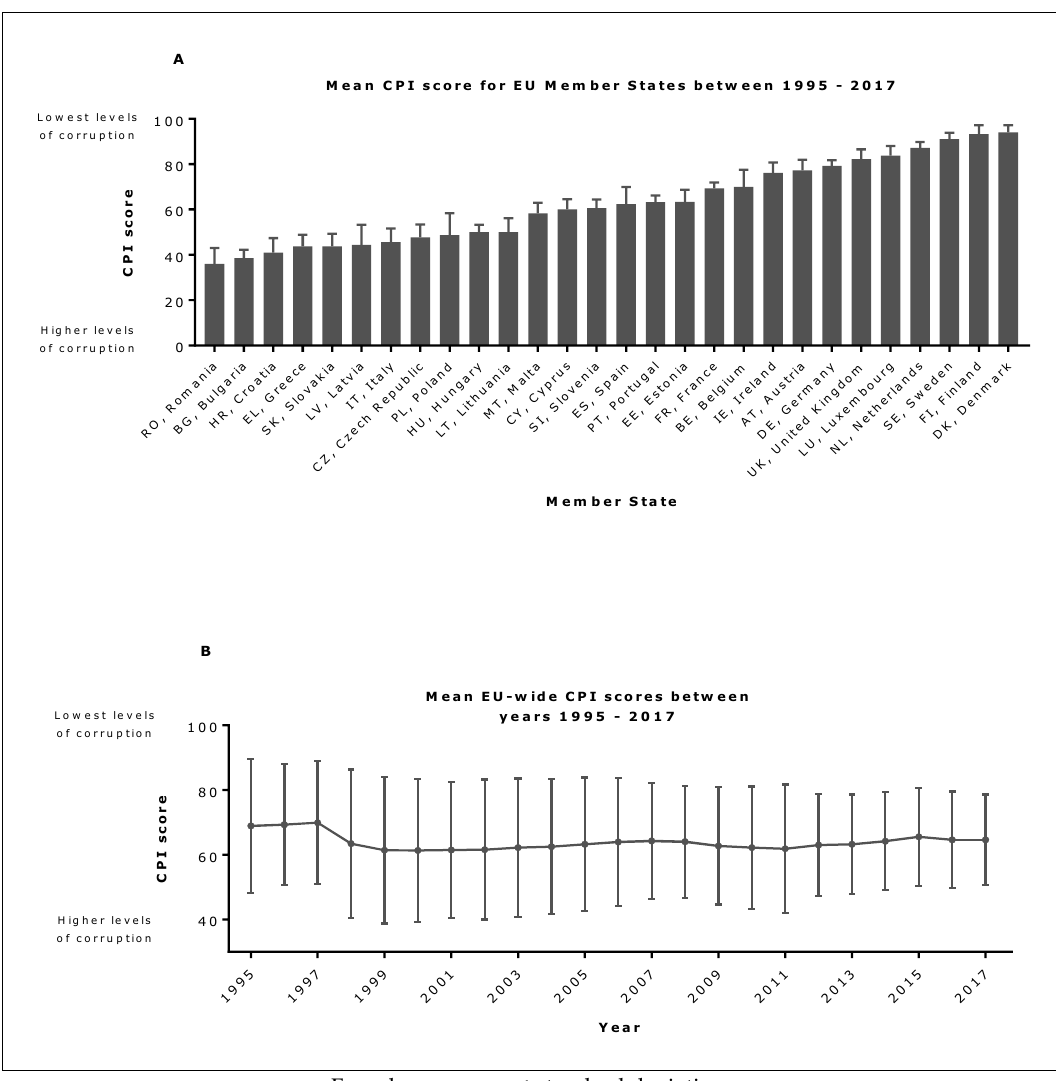
Error bars represent standard deviation. Figure 3. ( A ) Mean (1995–2017) Corruption Perceptions Index (CPI) scores for each EU Member State and ( B ) mean CPI scores EU-wide over time.